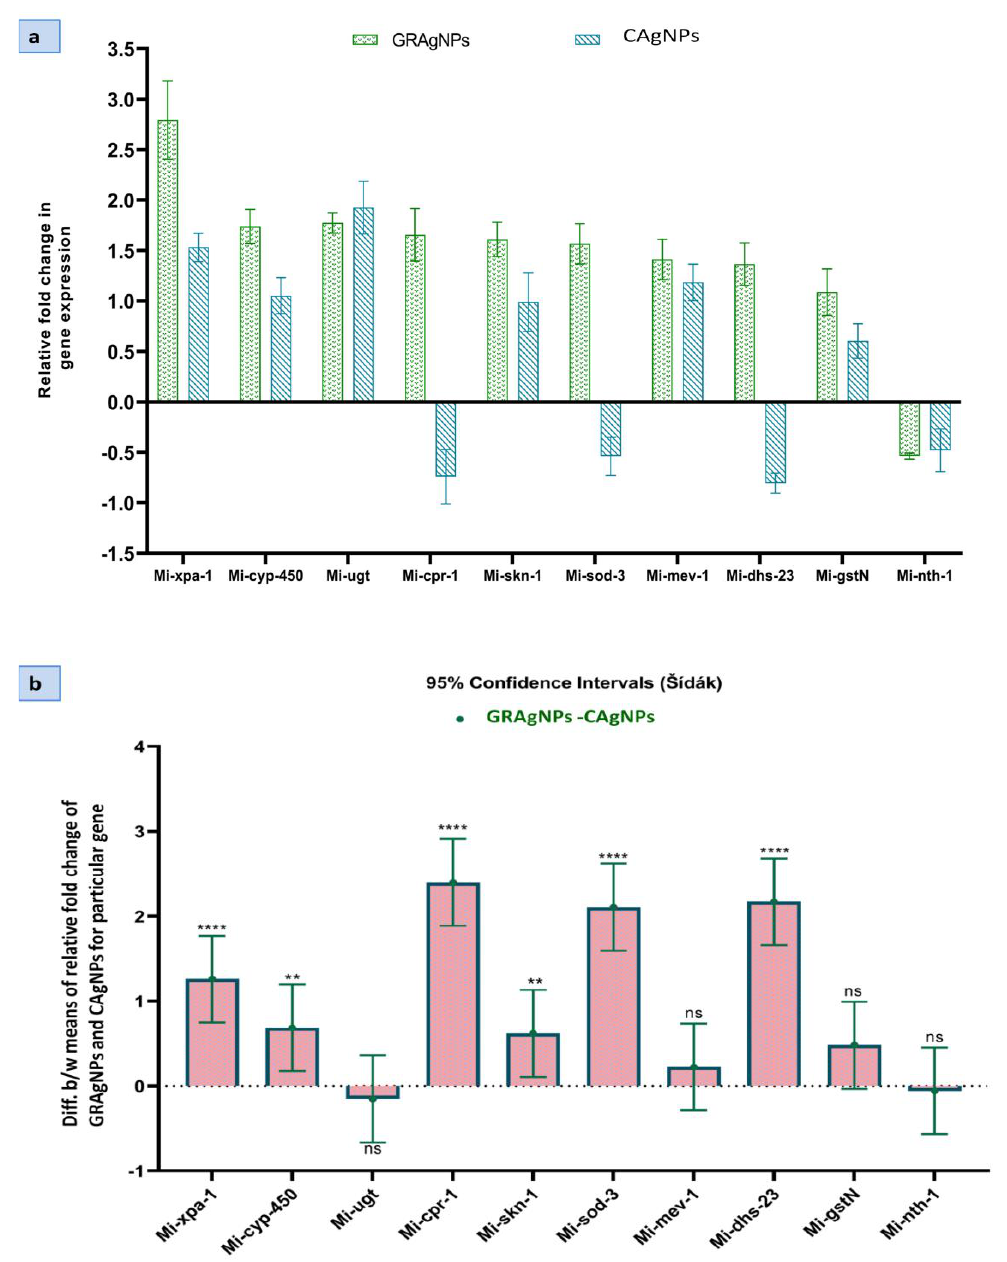
Figure 7. Comparative expression analysis of target genes in M. incognita exposed to silver nanoparticles synthesized using aqueous root extract of G. glabra , GRAgNPs (1 ppm) and, commercial silver nanoparticles, CAgNPs (1 ppm) for 4 hrs. ( a ) Relative fold change in expression. ( b ) 95% CI of difference between means of relative fold change of GRAgNPs and CAgNPs for a particular gene calculated using 2-way ANOVA with Šídák’s multiple comparisons test at α = 0.05 (where **** = p < 0.0001, ** = p < 0.01 and ns = non-significant).